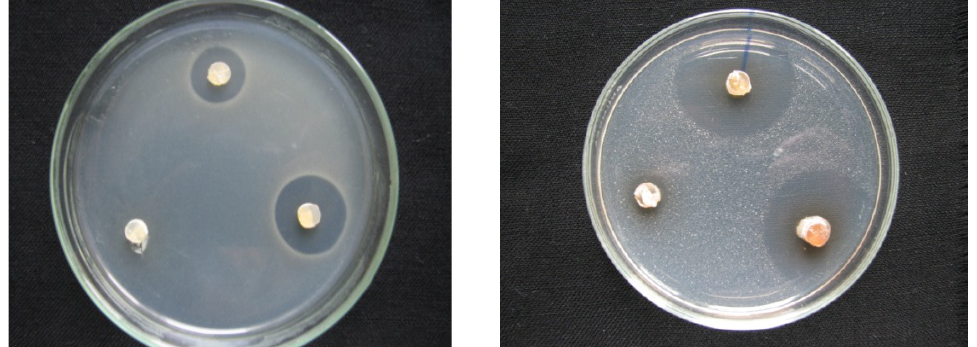
Group IA - antagonism in three habitats (neutral, saline and alkaline)